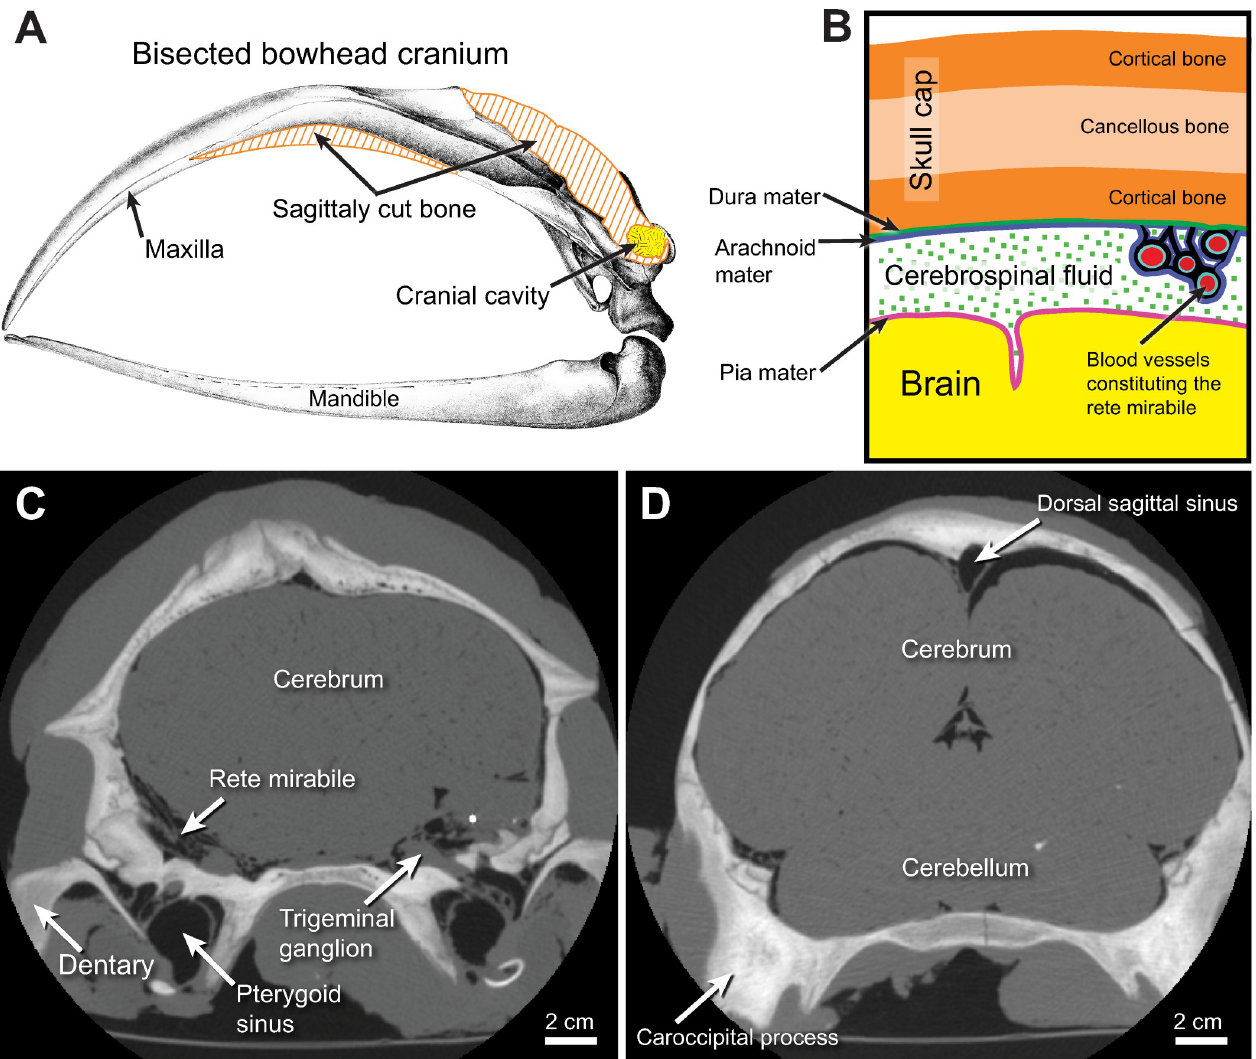
Fig 1. Cranial cavity and anatomy and beluga whale cranial CT scans. (A), line drawing of a bisected bowhead skull (modified Eschricht and Reinhardt [74]); (B), Illustration of cranial cavity components including membranes surrounding the brain; C-D, coronal CT scan slices through the head of a beluga whale (NSB-DWM 2019LDL10); (C) section through the root of the zygomatic arch. (D) more caudal section through the paroccipital